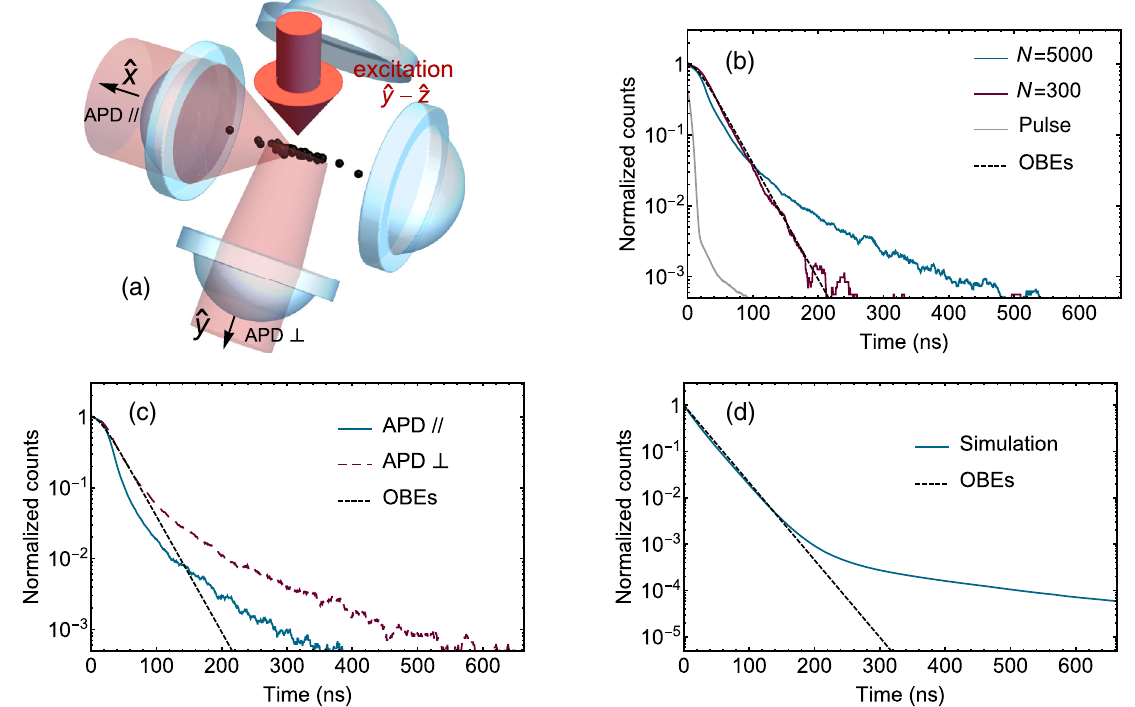
FIG. 1. (a) Schematics of the experimental setup. Four high-numerical-aperture (0.5) lenses collect the fluorescence emitted by the atomic cloud along two axes, which is then fiber-coupled to avalanche photodiodes (APD). The excitation beam is aligned in the vertical direction. The trap beam (not shown) propagates along x , which is also the first collection axis. The second collection axis is at 45° with respect to the excitation direction. (b) Number of photons collected in bins of 0.5 ns as a function of time after switching off the excitation light (saturation parameter s ≃ 27 ) for a cloud containing about 5000 (blue solid line) and 300 atoms (purple solid line), where data are represented with a moving average. These data are obtained by repetition of 20 pulses on 10000 clouds. Gray line: excitation pulse temporal shape. Dashed line: solution of the optical Bloch equations solved for our pulse shape. All curves have been normalized to their steady-state value during the excitation. (c) Time traces collected using the APD aligned along the y direction (APD ⊥ , long- dashed purple) and along x (APD//, solid blue). The dashed black line shows the solution of OBEs. (d) Numerical simulations of the experiment using a nonlinear coupled-dipole model [31,34] in an ensemble of 200 atoms with ρ 0 =k 3 ¼ 0 . 3 . Black dashed line: solution of optical Bloch equations for a single